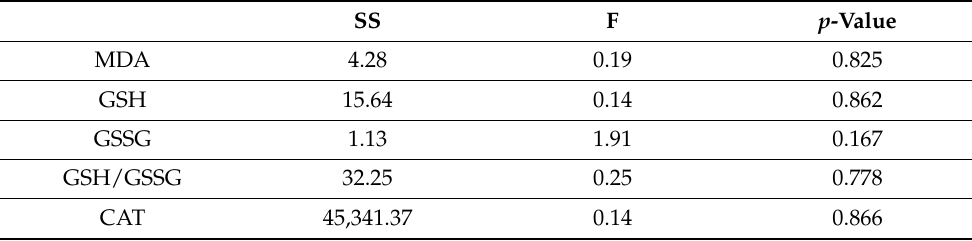
Table 3. Variance analysis for groups 3, 4 and 5 for all variables.